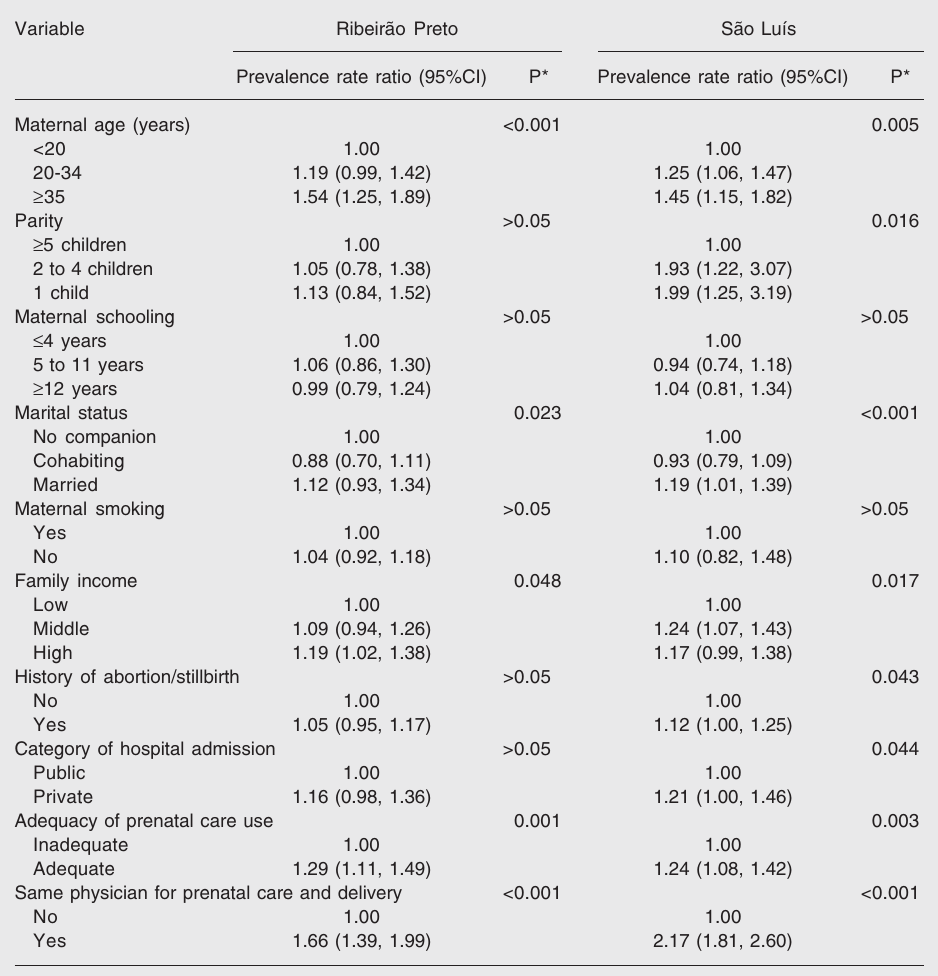
Table 2. Multivariable analysis of risk factors for cesarean section (Ribeirão Preto, 1994 and São Luís, 1997/ 1998). Variable Ribeirão Preto São